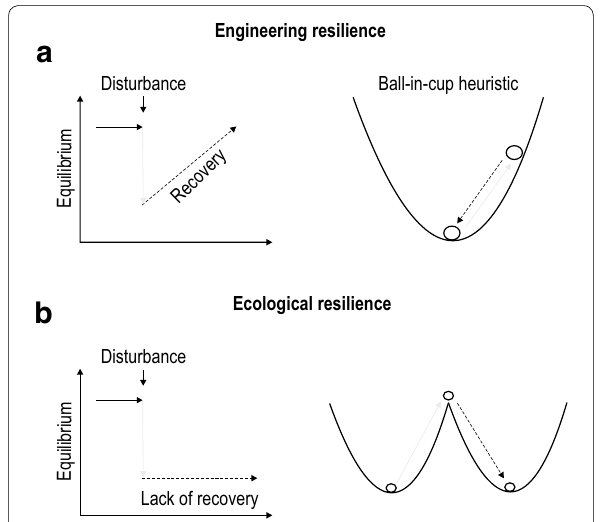
Fig. 1 Schematic distinguishing between ( a ) recovery (engineering resilience) and ( b ) ecological resilience. Panels on the left show sub‑ ject (humans, ecosystems) trajectories before (full black arrow), during (gray arrow), and after disturbances (black broken arrow). Panels on the right express these dynamics with ball‑in‑cup heuristics com‑ monly used in ecology. In the case of recovery/engineering resilience, the ball rolls back to its equilibrium position after a disturbance. In the case of ecological resilience, the ball rolls over the cup’s brink and falls into a new cup. This cup represents an alternative stable system regime from which recovery to the previous regime is impossible. This is symbolized with the ball not rolling back to the previous